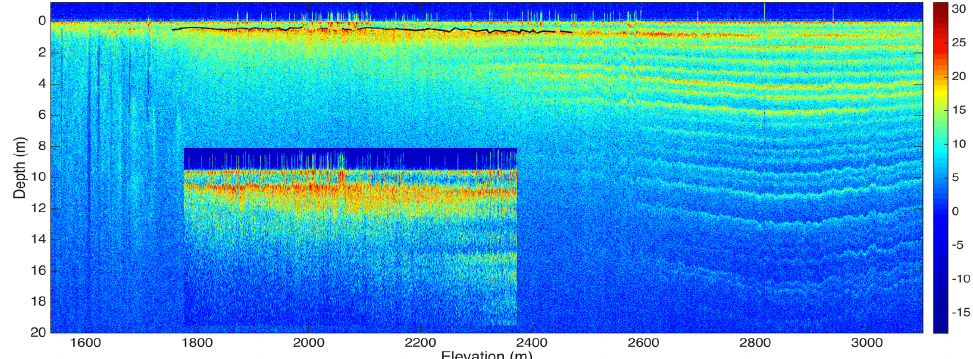
Figure 4. A transect in western Greenland showing Operation IceBridge Snow Radar response to the snowpack in 2011. The aerial survey extends (left to right) from the ablation zone to the dry snow zone. The color scale shows the relative power intensity (in dB). The black line shows the position where the melt layer (i.e. the top of the ice layer formed after the 2010 melt season) was retraced. Inset shows the upper ∼ 5m where the melt layer is located.